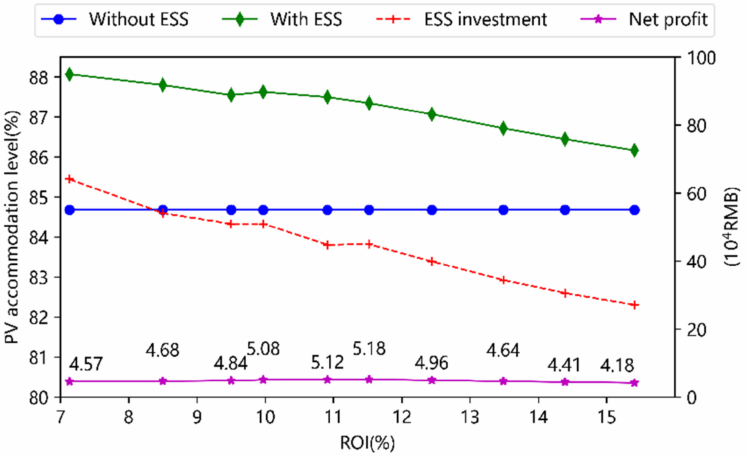
Figure 10. Configuration analysis of decentralized ESS under different ROIs.